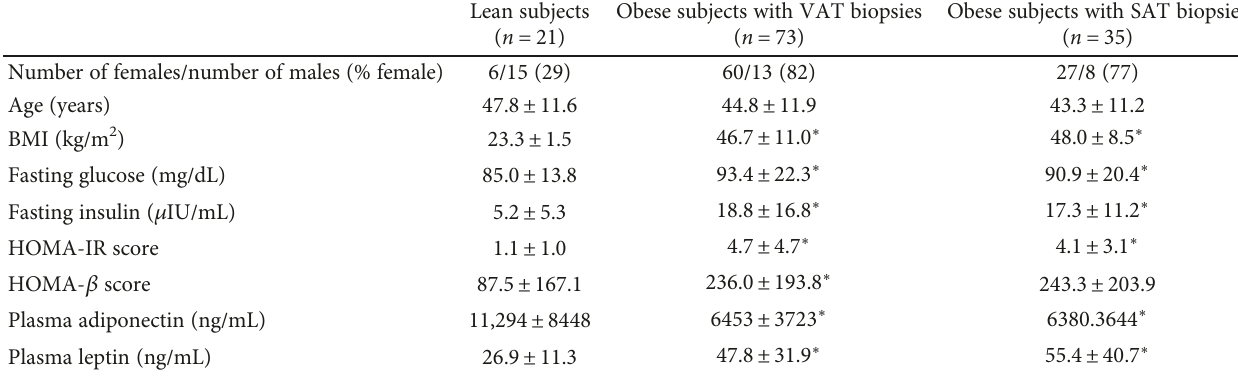
Table 1: Demographics and clinical characteristics of lean and obese